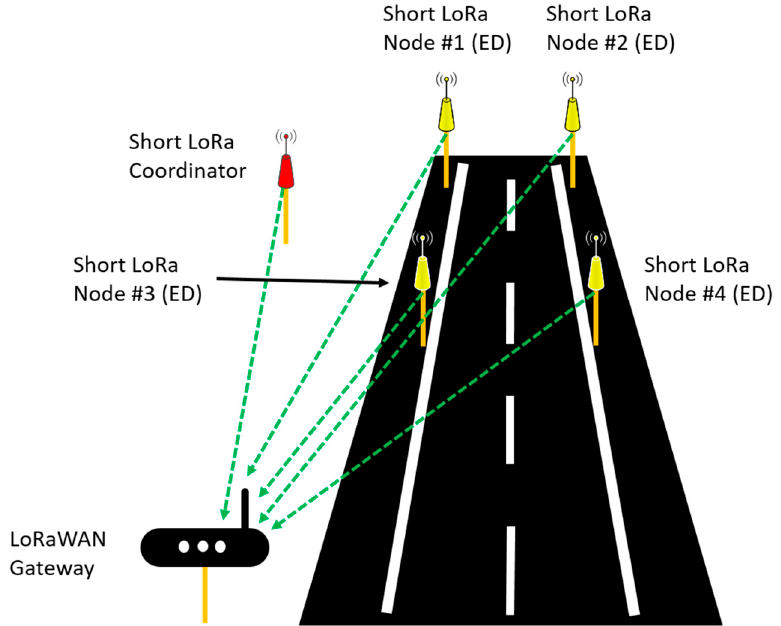
Figure 3. LoRaWAN standard topology.